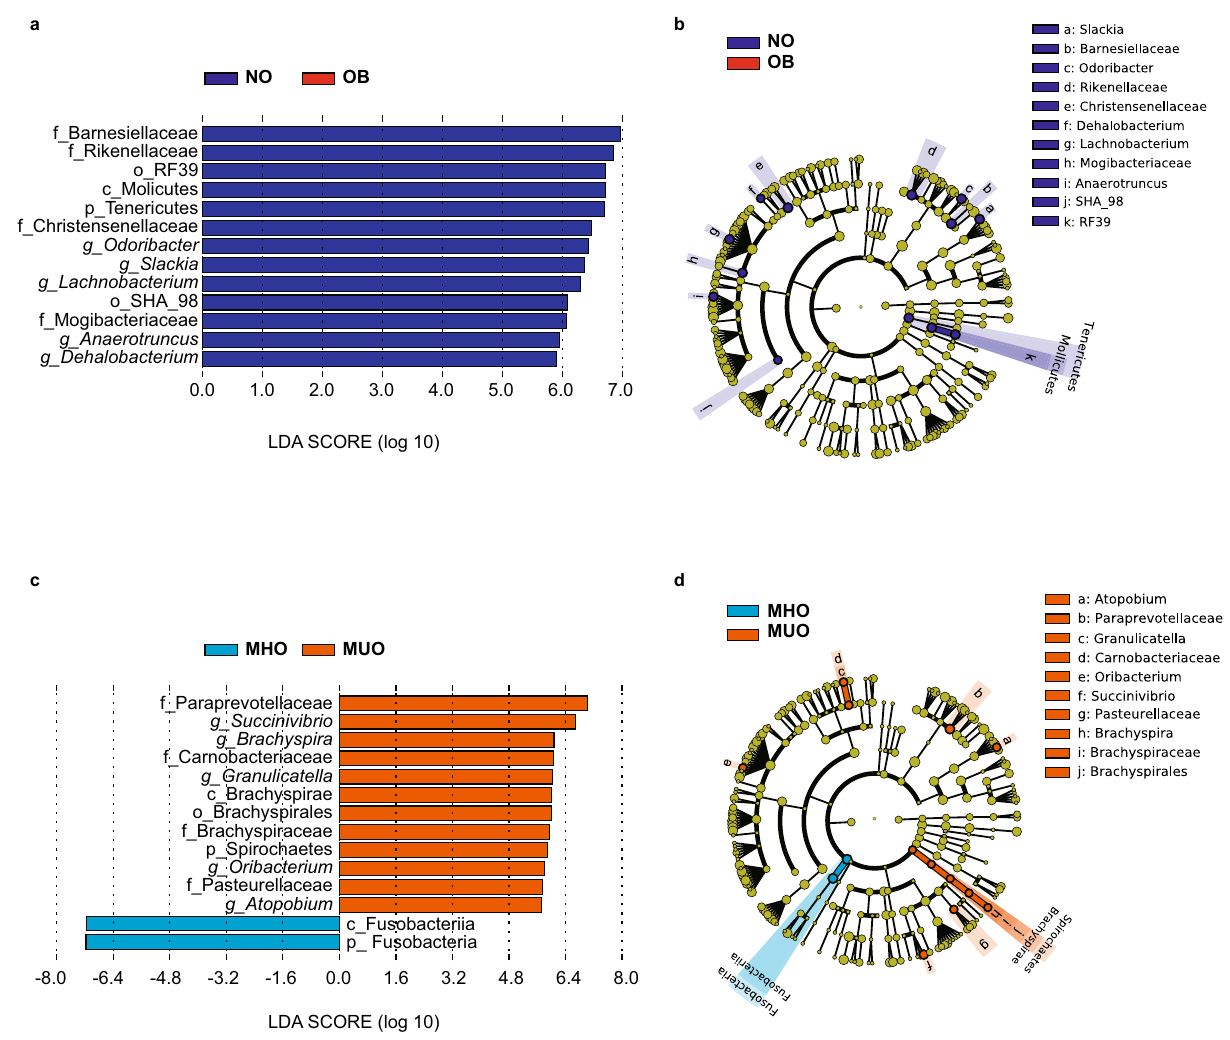
Figure 3. Linear discriminant analysis (LDA) score distribution of microbiome between ( a ) NO; non-obese (blue) and OB; obese (red), and ( c ) MHO; metabolically healthy obese (light blue) and MUO; metabolically unhealthy obese (orange). Alphabetical letters listed before the name of the enterobacteria represent p_; phylum, c_; class, o_; order, f_; family, and g_; genus levels. Linear discriminant analysis effect size (LEfSe) analyses of gut microbiota and Cladogram indicating statistical differences of the microbial populations between ( b ) NO; non-obese (blue) and OB; obese (red), and ( d ) MHO; metabolically healthy obese (light blue) and MUO; metabolically unhealthy obese (orange). Cladograms show the phylogenetic distribution of bacterial lineages associated with groups from kingdom, phylum, class, order, family, and genus levels are listed in kingdom from inside to outside of the cladogram. NO; non-obese (blue) (n = 81), OB; obese (red) (n = 59), MHO; metabolically healthy obese (light blue) (n = 54) and MUO; metabolically unhealthy obese (orange) (n = 21). Graphics were made using the Galaxy/Hutlab (https:// hutte nhower. sph. harva rd. edu/ galaxy/). p < 0.05, LDA score >